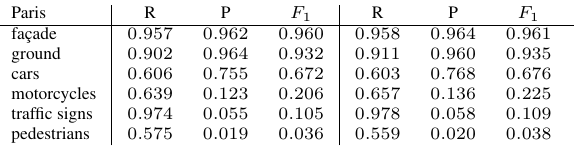
Table 10: Recall (R), precision (P) and F 1 -score for RF-based classification involving all 21 features (left) and only the features in S CFS (right).